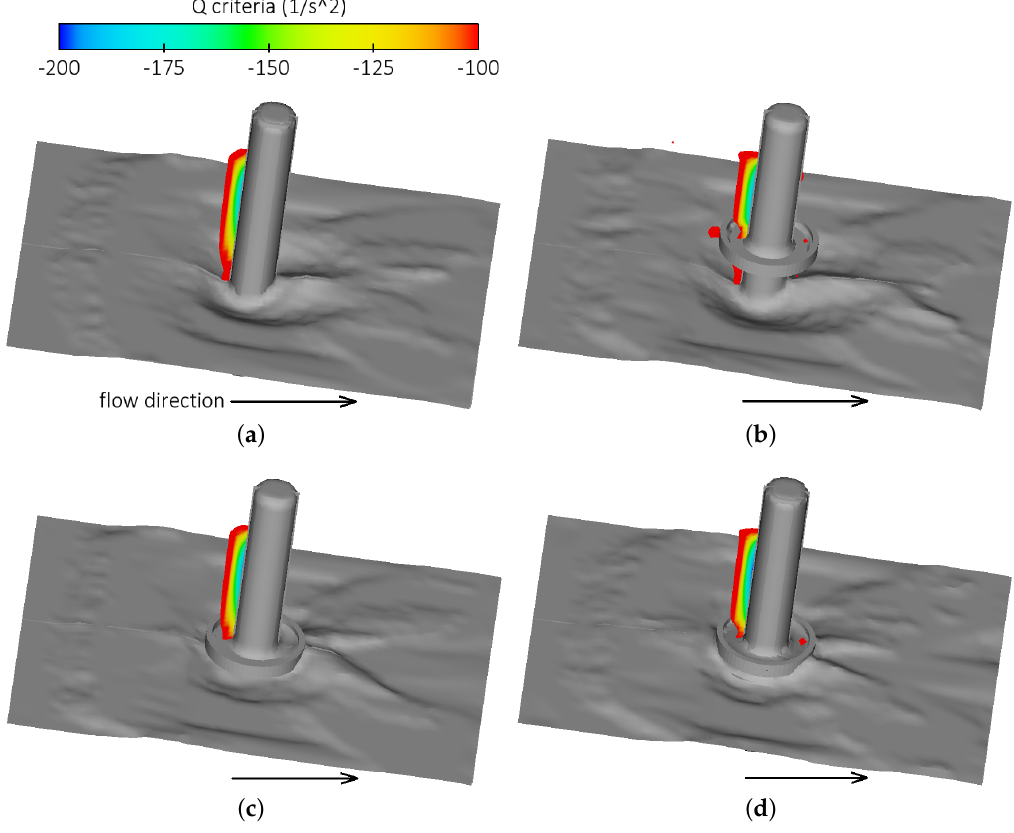
Figure 6. Visualization of vortices: ( a ) no hooked-collar; ( b ) single hooked-collar at 0.25 b ; ( c ) single hooked-collar at bed level; and ( d ) double collar at the bed and buried 0.25 b